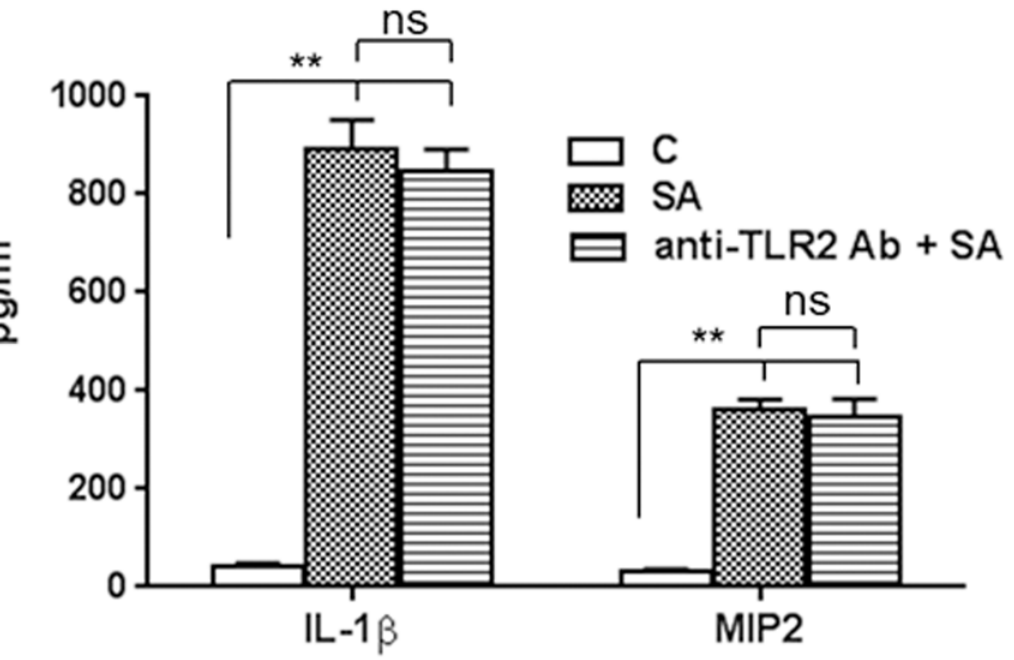
Fig 7. Effect of TLR2 neutralization on inflammatory responses towards S. aureus. 661W cells were challenged with SA for 8 h following neutralization of TLR2 using anti-TLR2 neutralizing antibody. The expression of secretory cytokines and chemokines were measured by ELISA in the conditioned medium. Statistical analysis was performed using one-way ANOVA ( ** , p < 0.005; ns, not